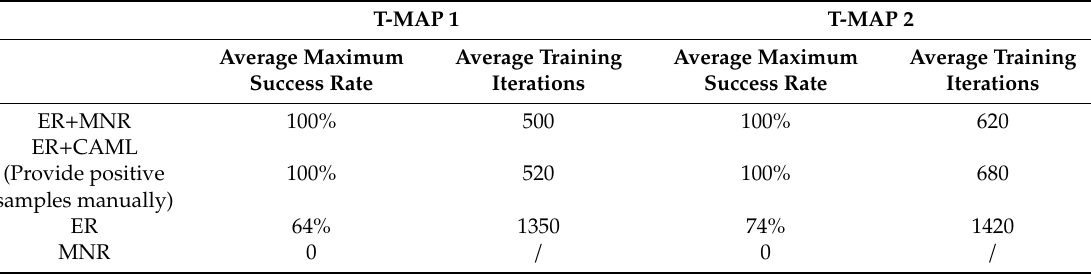
Table 2. Training e ff ects on di ff erent